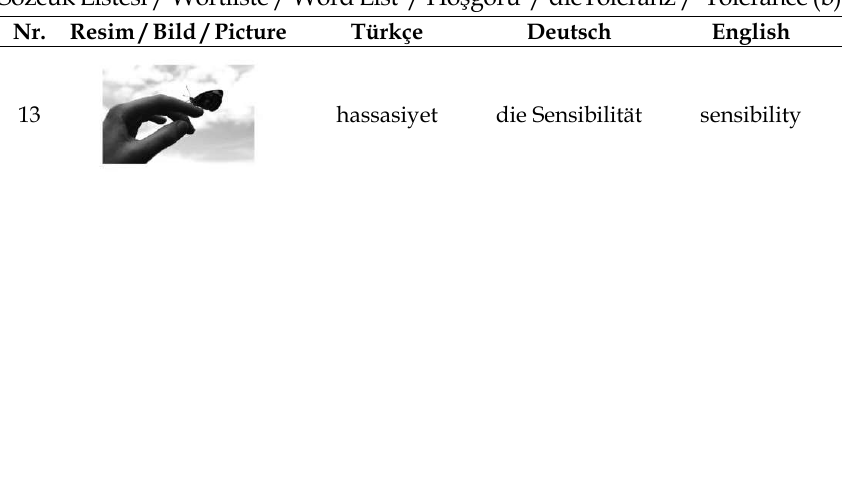
Table 3. Second group of words for